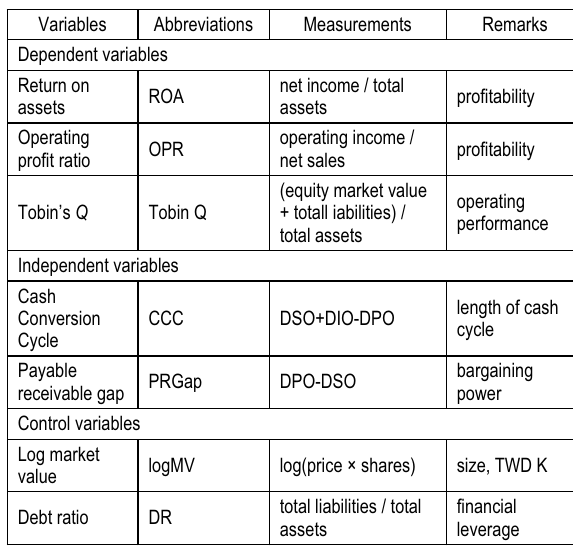
Table 2. Description of variables